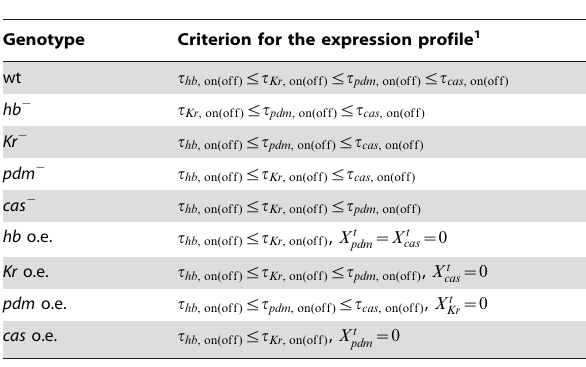
Table 3. Criterion for expression profile in each genotype.